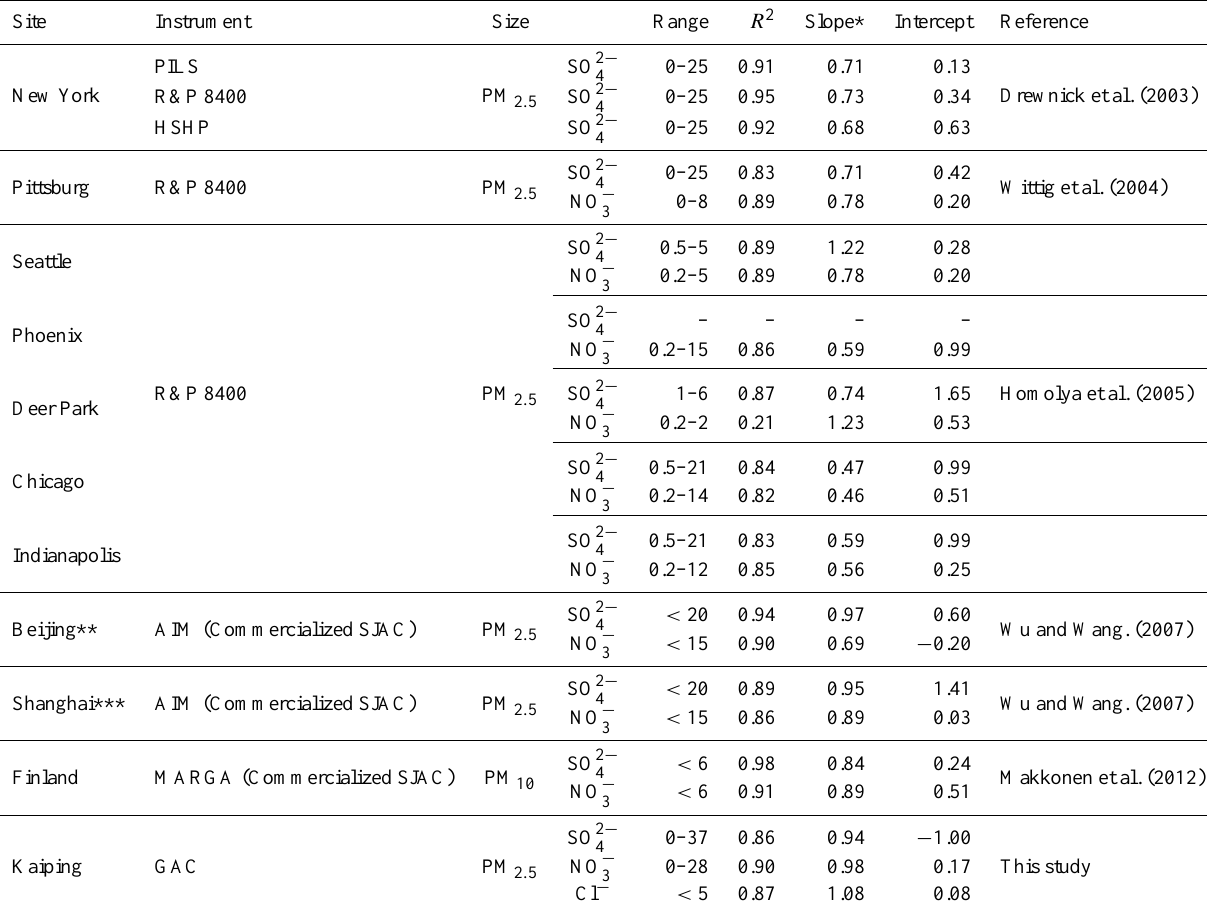
Table 3. Summary of inter-comparison results of semi-continuous instrument with filter-based method.